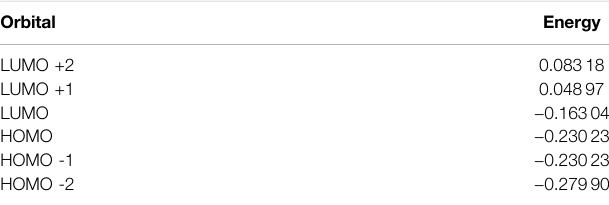
TABLE1| Energies(inHartree)ofmolecularorbitalsinthediiodinemoleculeatthe M06 – L/UGBS1p//M06 – L/def2 – QZVPPD level of theory. Orbital